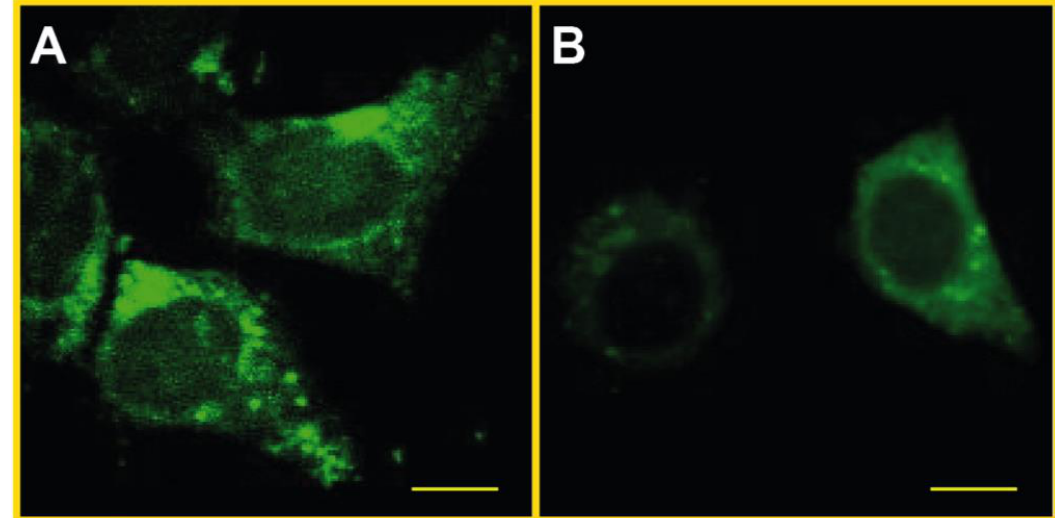
Figure 11. Confocal microscopy of N2a cells stained with the amyloid dye FSB with exogenous Aβ treatment. Panel ( A ) shows cells stained with FSB 24 hours after the addition of 1 μM Aβ. Panel ( B ) shows cells that were treated with 1 μM Aβ + 2 μM SLF and stained with FSB 24 hours later. Bright green dots in ( A ) show a cytoplasmic, perinuclear distribution indicative of intracellular uptake of exogenous Aβ. Scale bars represent 10 μm.